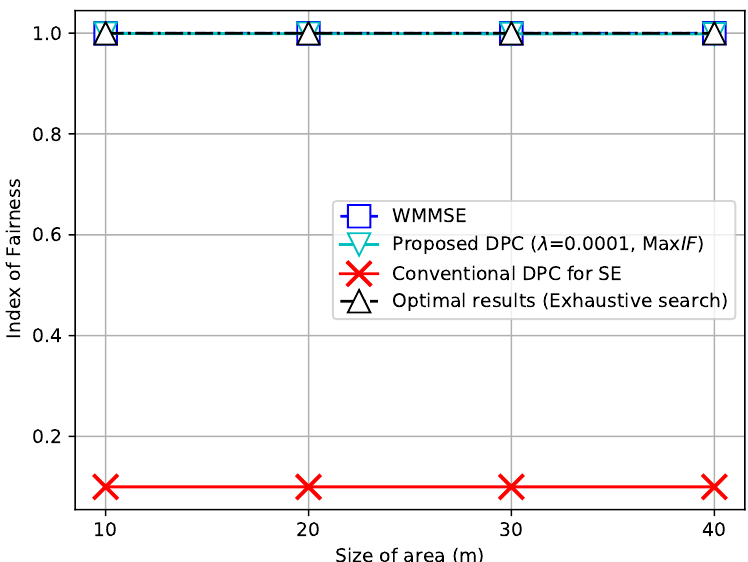
Figure 10. Index of fairness of the conventional and proposed schemes for α = 5 in Rayleigh fading channels.